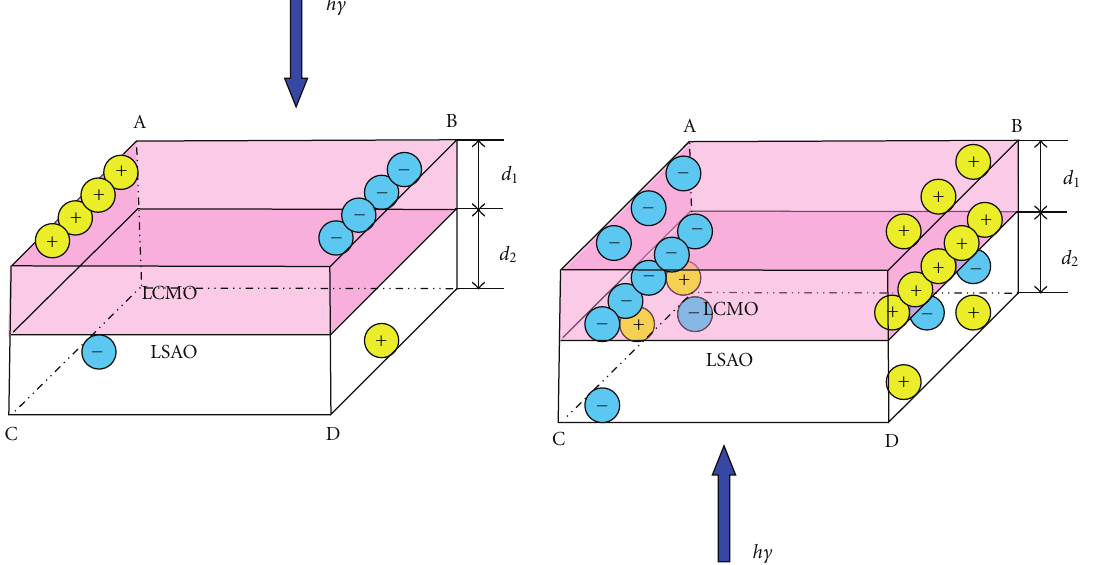
Figure 5: The schematic drawing explaining carries distribution under opposite irradiation directions.